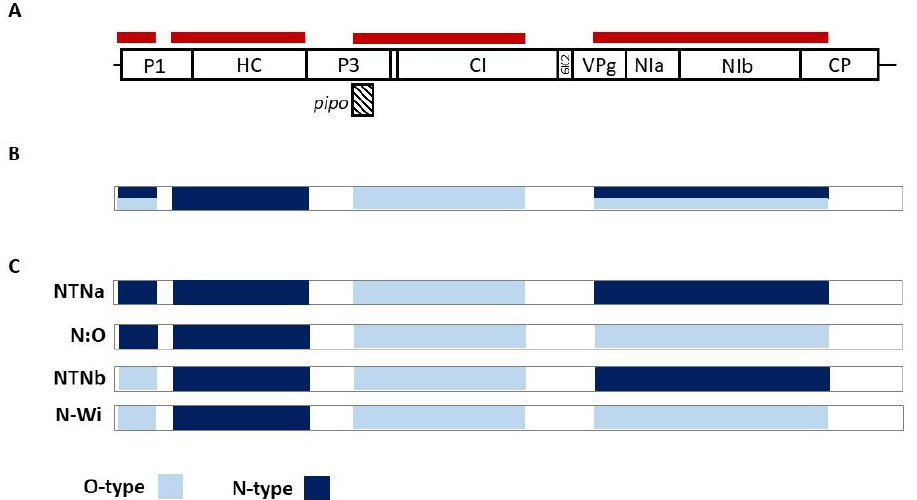
Figure 2. Analysis of samples showing multiple infections by PVY strains. ( A ) Schematic representa- tion of the positions of informative regions (red stripes) along the PVY genome used for PVY-O- and N-specific mapping of HTS reads ( B ) Graphical representation of obtained sequences from samples T1, T40, and T62, where positions with more than one variant detected are shown (azure/dark blue) ( C ) Possible recombination patterns of PVY variants present in T1, T40, and T62 samples.